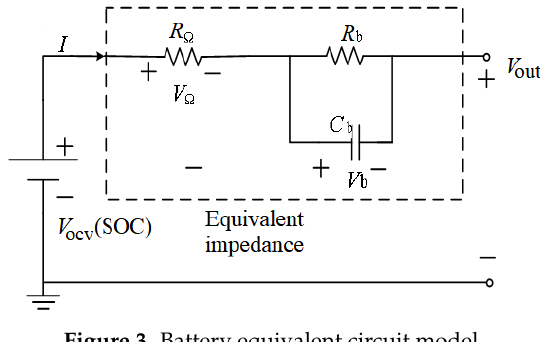
Figure 3. Battery equivalent circuit